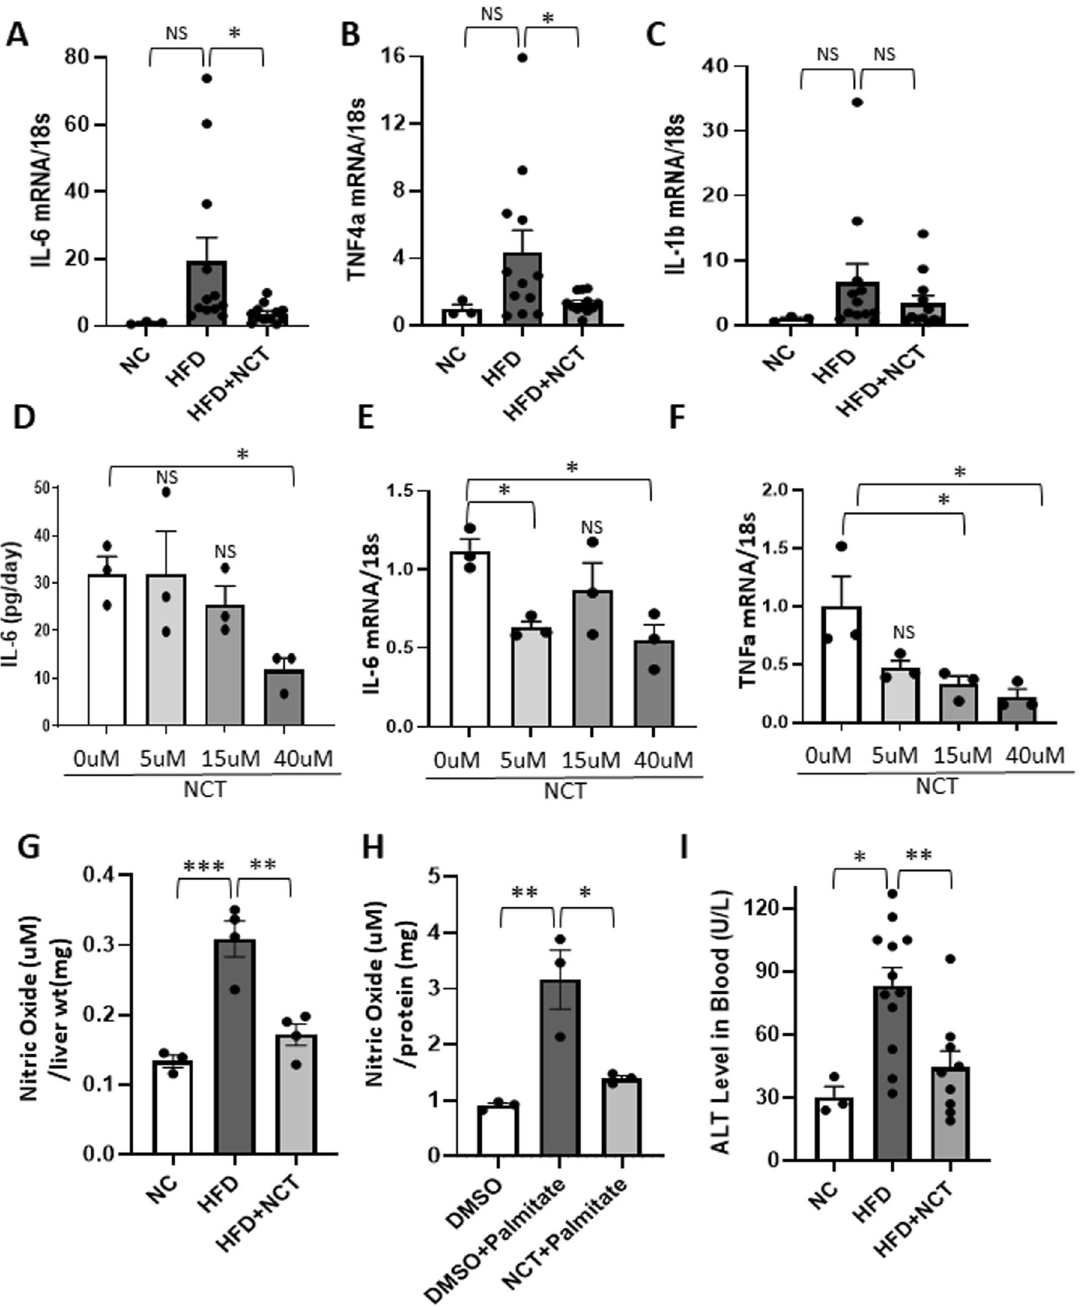
Fig. 5 NCT reduced in fl ammatory markers in mouse livers and human primary hepatocytes. A – C qPCR analysis in mouse liver of IL-6 , TNF α , and IL-1 β mRNA levels normalized to 18s rRNA (NC, N = 3, HFD and HFD + NCT, N = 12). D ELISA analysis for IL-6 secreted into the medium of human primary hepatocytes cultured in palmitate and DMSO (vehicle control) or different concentrations of NCT ( N = 3). E , F qPCR analysis of IL-6 and TNF α mRNA level in primary human hepatocytes. Normalization was to 18s rRNA ( N = 3). G , H Nitric oxide (NO) analysis in in vivo and in vitro. NO expression normalized to liver weight in vivo (NC, N = 3; HFD and HFD + NCT, N = 4) and normalized to protein in T6PNE cells in vitro ( N = 3). I Alanine aminotransferase (ALT) level in blood was reduced in HFD + NCT mice compared to HFD mice (NC, N = 3; HFD, N = 12; HFD + NCT, N = 9). Dots indicate individual mouse or human donors. Values represent the mean ± SEM. * p < 0.05, ** p < 0.01, *** p < 0.001 (HFD vs. NC or HFD + NCT, 0 μ M vs. each concentration of NCT in human hepatocyte and T6PNE cells). NS non-signi fi